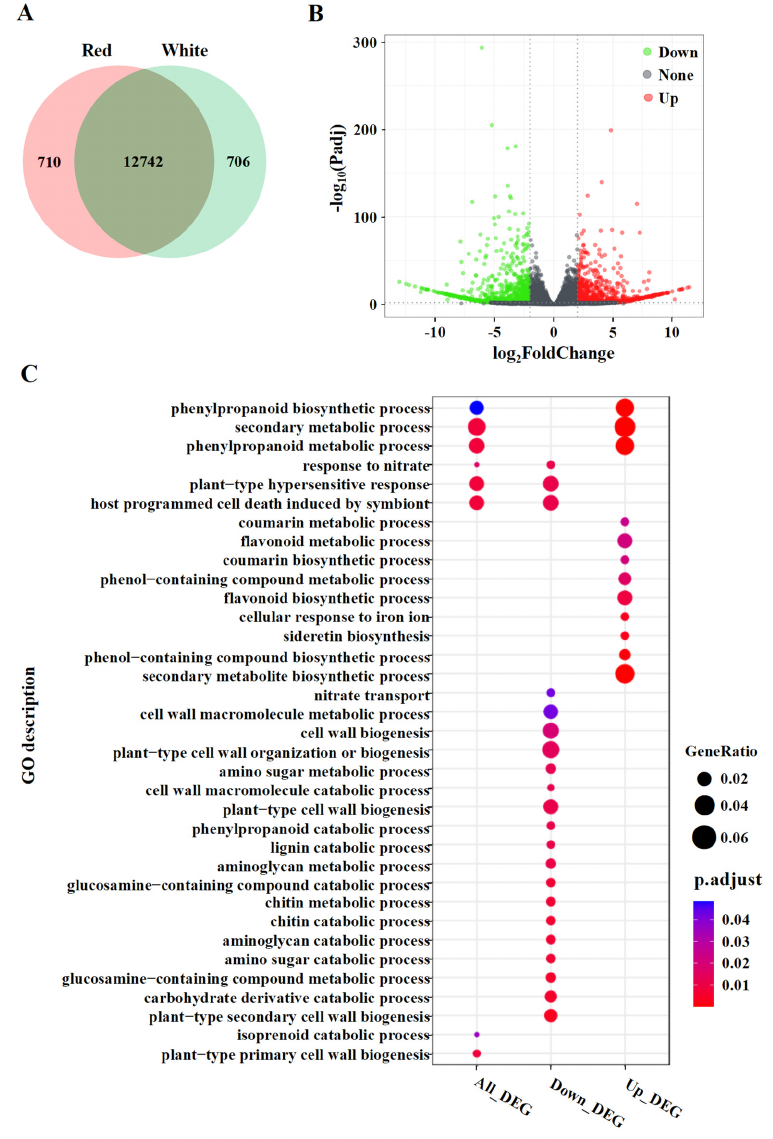
Figure 4. Gene expression analysis and GO annotation of DEGs in pomelo fruits. ( A ) Venn dia- gram of genes. ( B ) Volcano plot of genes. ( C ) GO annotation of DEGs. of genes. ( B ) Volcano plot of genes. ( C ) GO annotation of